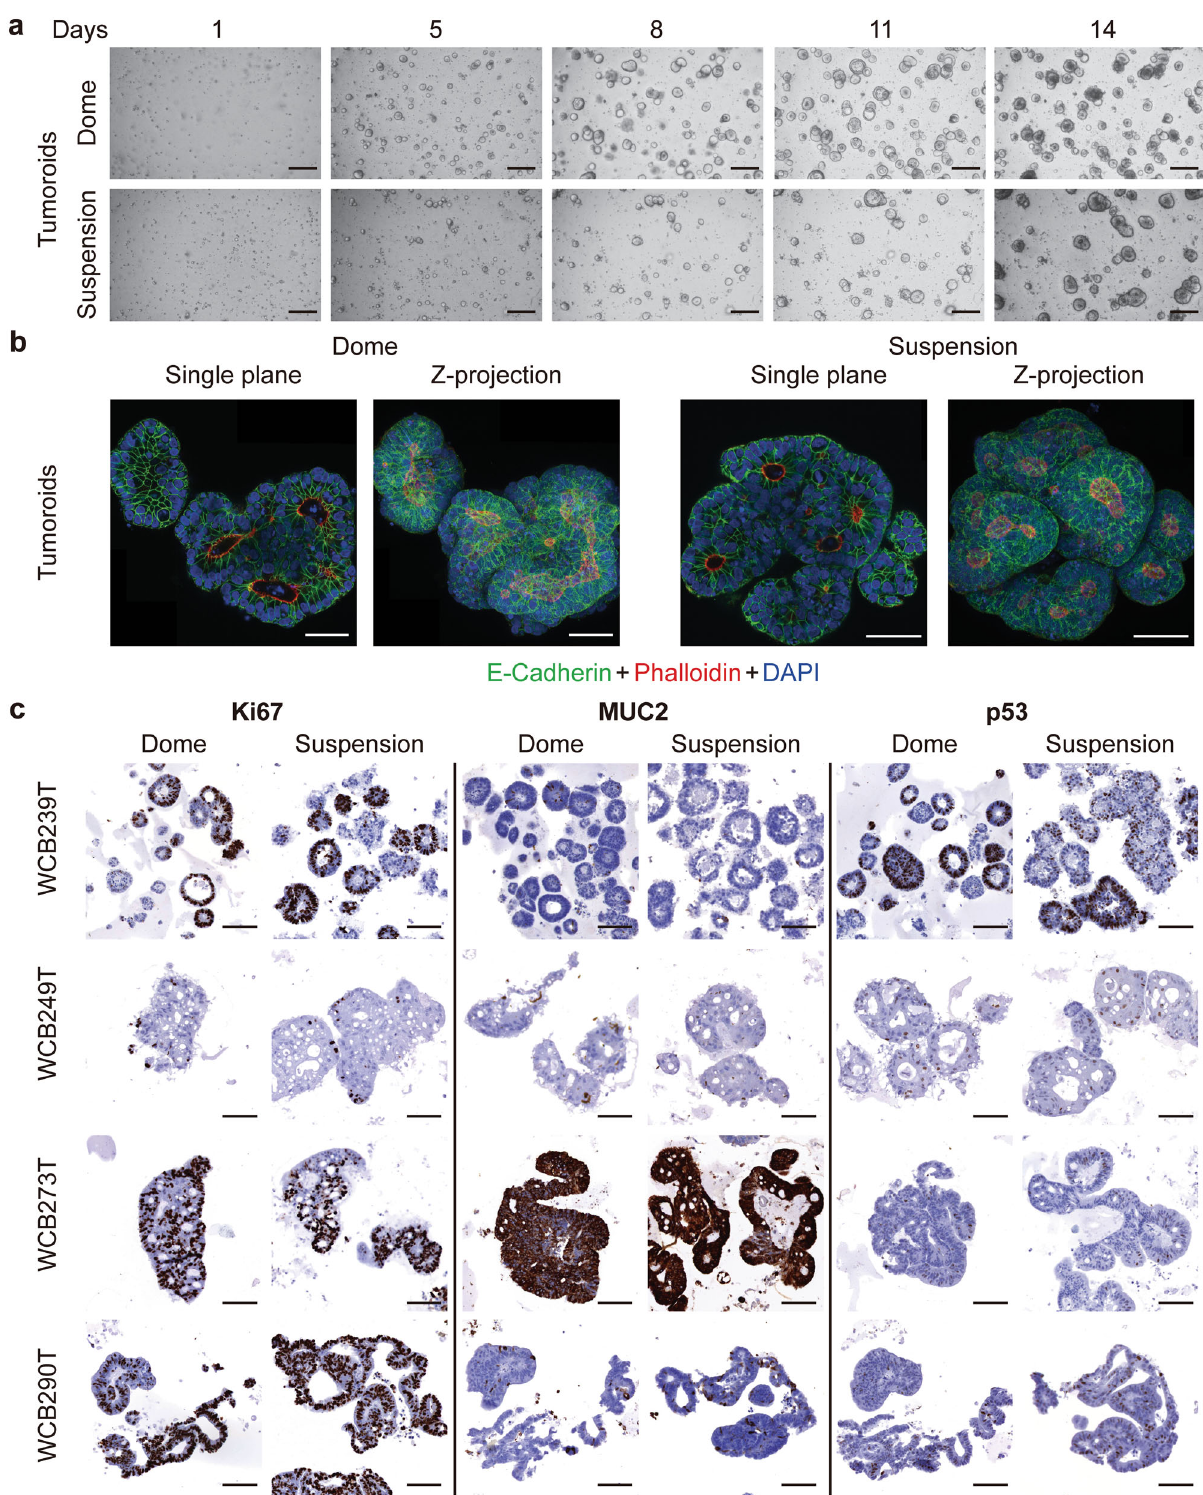
Fig. 4 Colorectal tumoroids grown in low-viscosity matrix suspension recapitulate morphological development observed in dome culture. a Representative bright- fi eld images of tumoroids grown in either LVM suspension or dome culture over a 14-day period; scale bars, 200 μ m. b Immuno fl uorescence microscopy images of tumoroids grown as LVM suspension cultures for 21 days stained with phalloidin, DAPI and E-cadherin antibody; scale bars, 50 μ m. c Immunohistochemistry for tumoroids from four patients stained for Ki67, MUC2, and p53; scale bars, 100 μ m. T